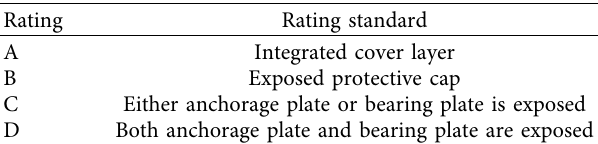
Table 7: Description of exposure ratings of the anchor head